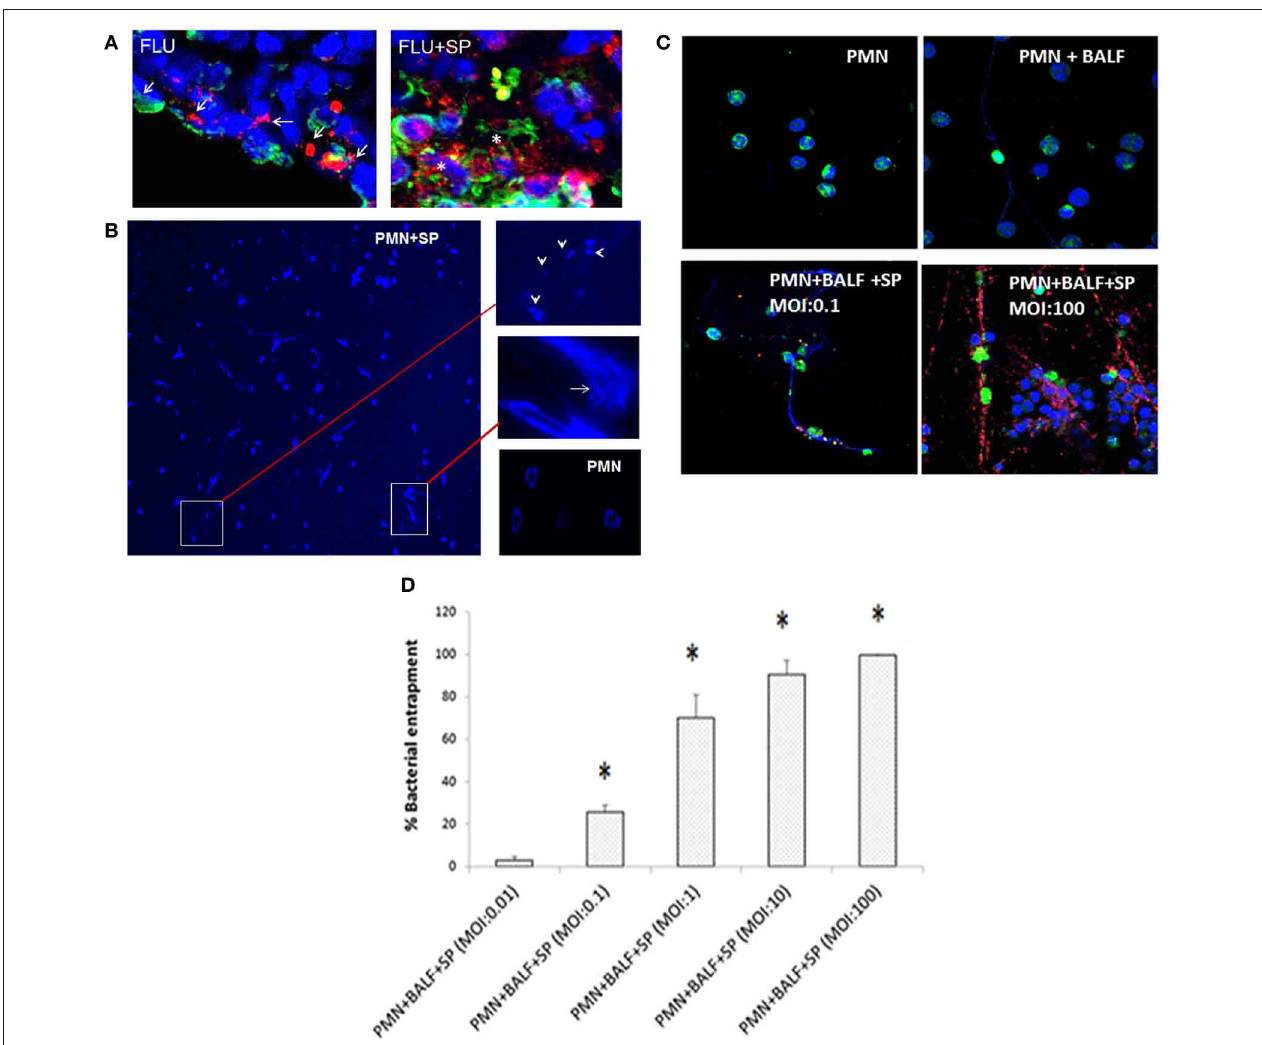
FIGURE 3 | Partial degradation of NETs and bacterial entrapment within NETs associated with S. pneumoniae 19F. (A) Lungs of mice infected with influenza alone (FLU) exhibit continuous staining (arrows) of MPO (red) and histone H2B (green). However, lungs of mice with viral and bacterial co-infection (FLU + SP) revealed large clusters of NETs often filled with degraded DNA, appearing as punctate staining (asterisks) of MPO and histone H2B. (B) To ascertain whether S. pneumoniae and other bacterial species cause NETs degradation, neutrophils were isolated from the lungs of influenza-infected mice (Narasaraju et al., 2011), incubated with S. pneumoniae , K. pneumoniae , P. aeruginosa , or S. aureus at a neutrophil:bacterial ratio of 1:10, and stained with DAPI. Extensive NETs were notable when neutrophils were incubated with S. pneumoniae (PMN + SP), compared with incubation with the other 3 bacterial species (data not shown). NETs were negligible for the untreated neutrophils (PMN) serving as negative control. Partially degraded NETs were observed when incubated